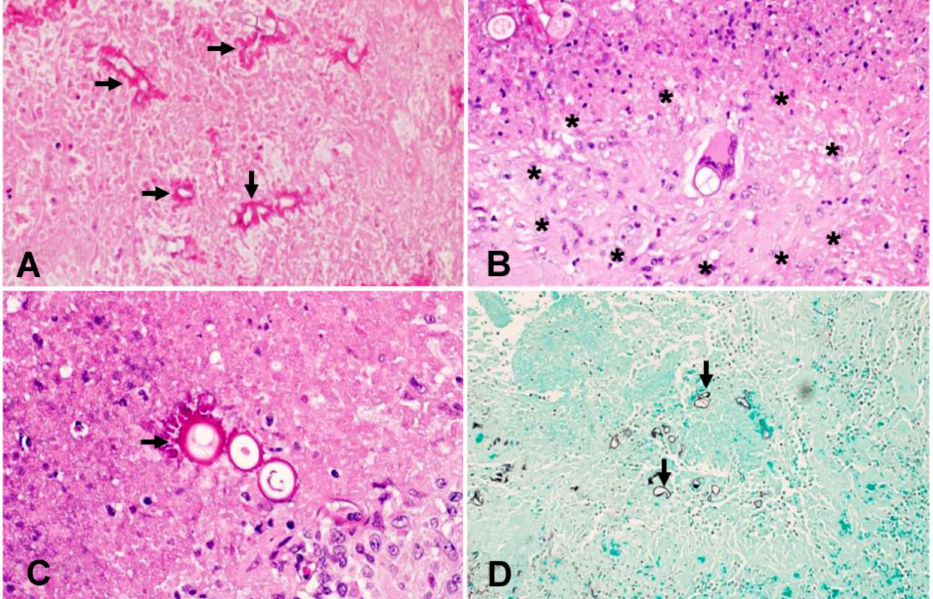
Figure 3. Histopathology findings of a section of small intestine: ( A ) HE stain (4 × ), within the necrotic areas, there are numerous fungal elements (arrows) invading all the layers beyond the mucosa. The fungi are characterised by thin walls and broad septate hyphae in keeping with basidiobolomycosis. ( B ) HE stain (40 × ), the fungal hyphae are associated with dense fibro-inflammatory reaction with numerous necrotising granulomas. In this image, a granuloma’s border is marked by asterisks. ( C ) HE stain (40 × ), hyphae are frequently surrounded by eosinophilic material known as Splendore– Hoeppli phenomenon (arrow). ( D ) GMS stain (20 × ), the fungi appear black with GMS stain (arrows). HE: haematoxylin and eosin; GMS: Gomori methenamine